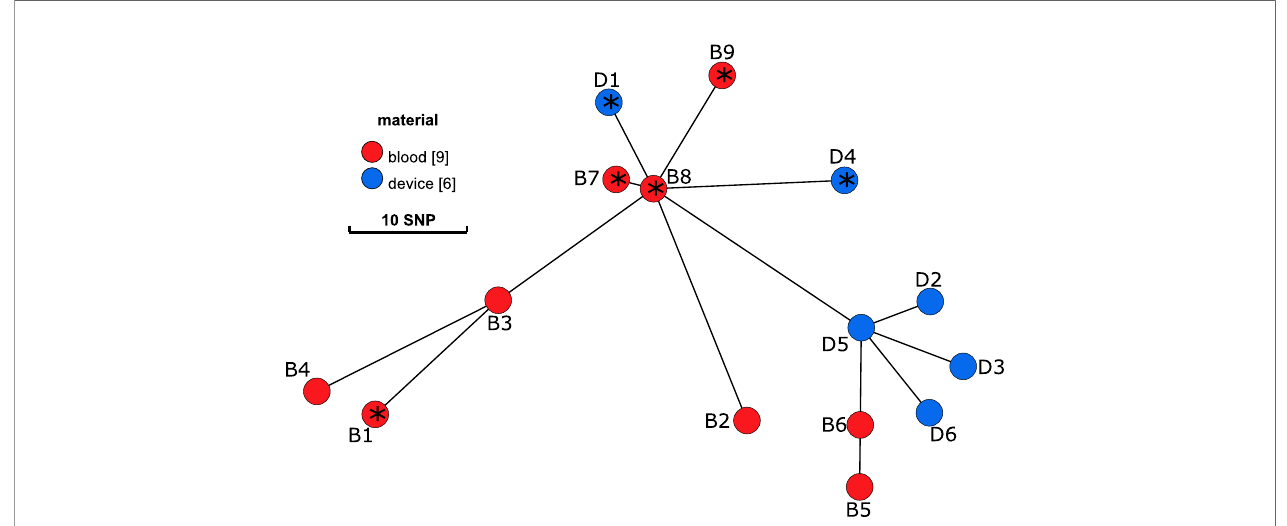
FIGURE 1 | Minimum spanning tree on the sequences of S. aureus isolates. Blood culture isolates (B1-B9) are displayed in red and isolates from the internal cardioverter de fi brillator (device, D1-6) in blue. Distance between nodes in SNPs. According to results of the WGS, isolates with an * present an insertion of a prophage within the gene hlb .